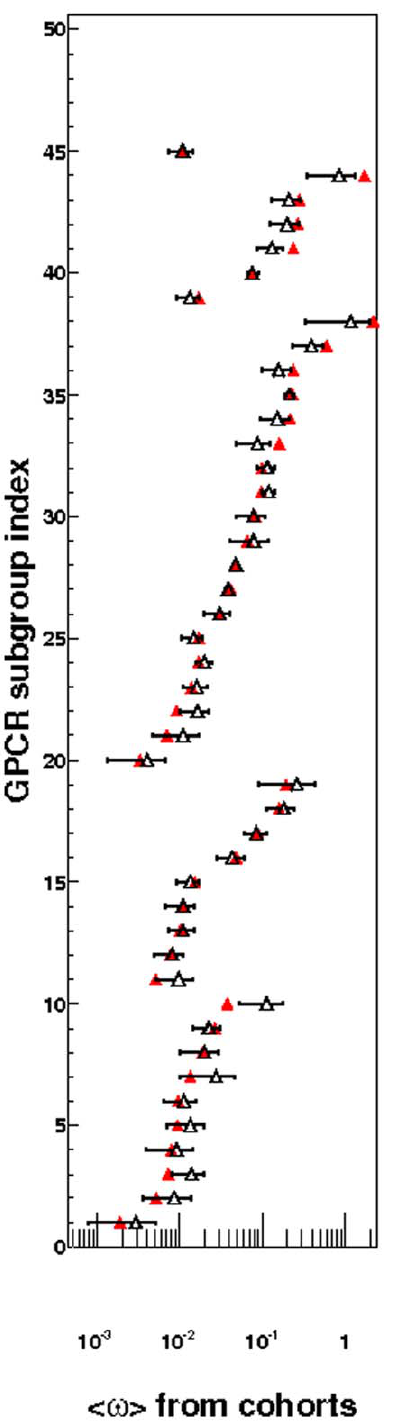
Figure 2. The average v of key positions ( , v key . ) contrasted with average v of randomly selected 7TM positions ( , v ran- dom7TM . ). Results of selection pressure, from PAML’s model M7, for subgroups 1–45 and listed in Tables 1, 2, 3 and 4 are shown above. Results from model M8 were obtained for subgroups 38 and 44. Filled triangle represents , v key . while open triangle represents the average of the average from random cohorts (from the , v random7TM . distribution). The error bar represents two standard deviations (2 s random7TM ) or the 95% confidence interval from v random7TM